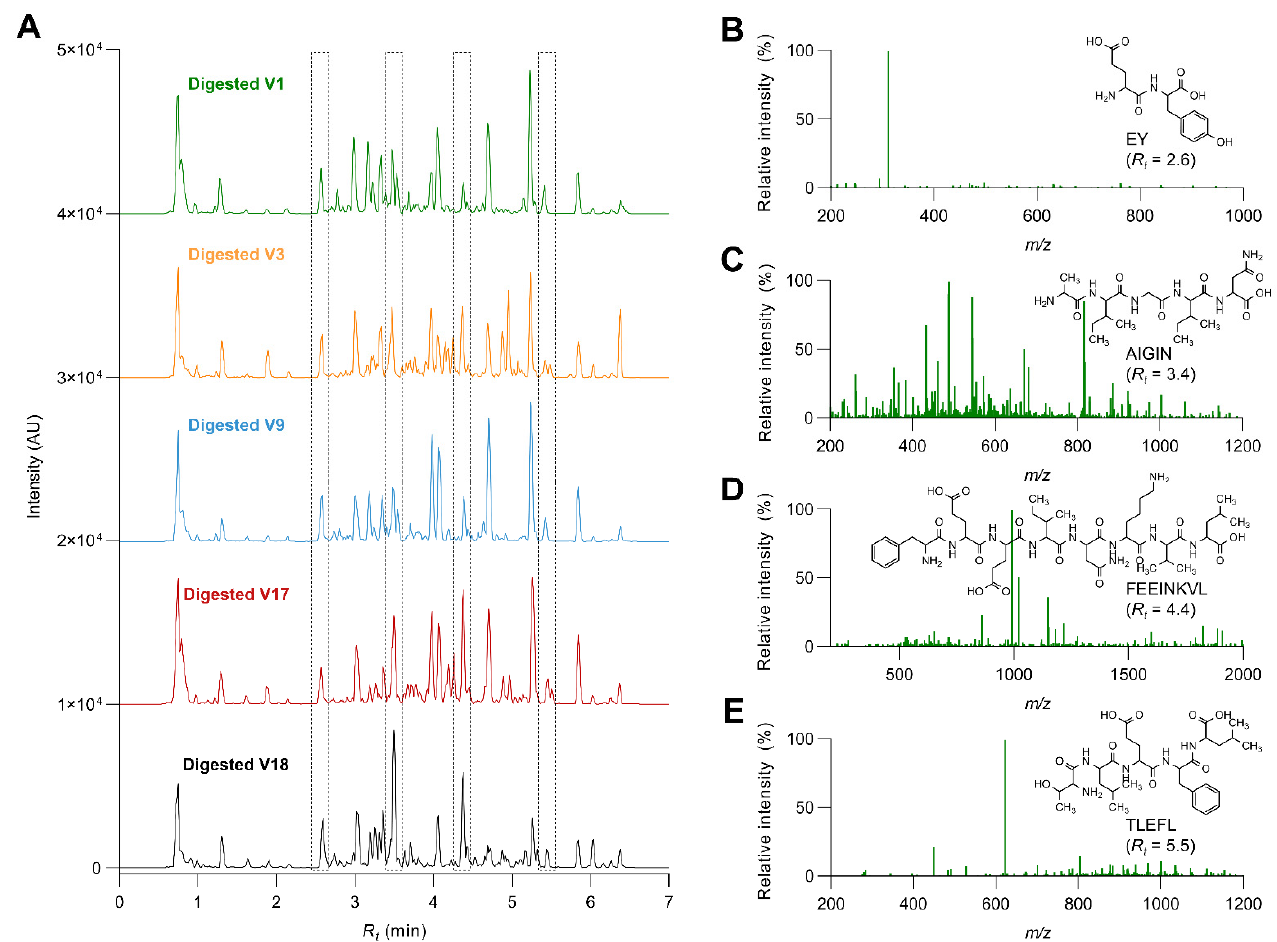
Figure 3. Representative chromatograms of the selected soybean varieties ( A ) and mass spectra of the main peaks (framed ones) identified in the soybean varieties digested under gastrointestinal conditions ( B – E ).